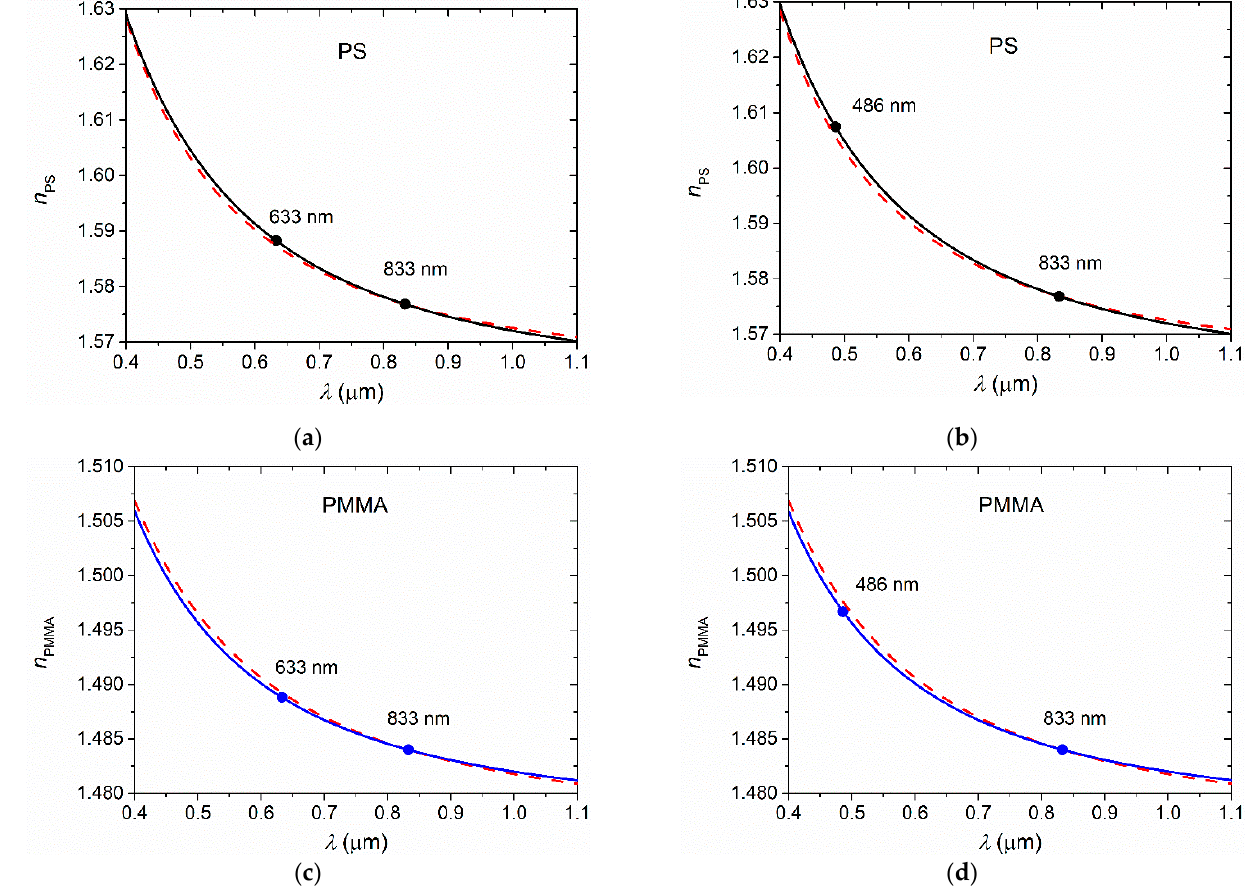
Figure 2. Dispersion curves for polymers PS ( a , b ; black solid lines) and PMMA ( c , d ; blue solid lines), obtained with the two-coefficient Cauchy model, assuming known n 833 , and with n 633 ( a , c ) or n 486 ( b , d ) calculated with Equations (3) or (4), respectively. Full circles correspond to known n values ( n 833 ) and calculated n ones ( n 633 or n 486 ). To illustrate the validity of the model the precise dispersion curves of these two polymers (taken from Figure A1) are also included (red dashed lines).